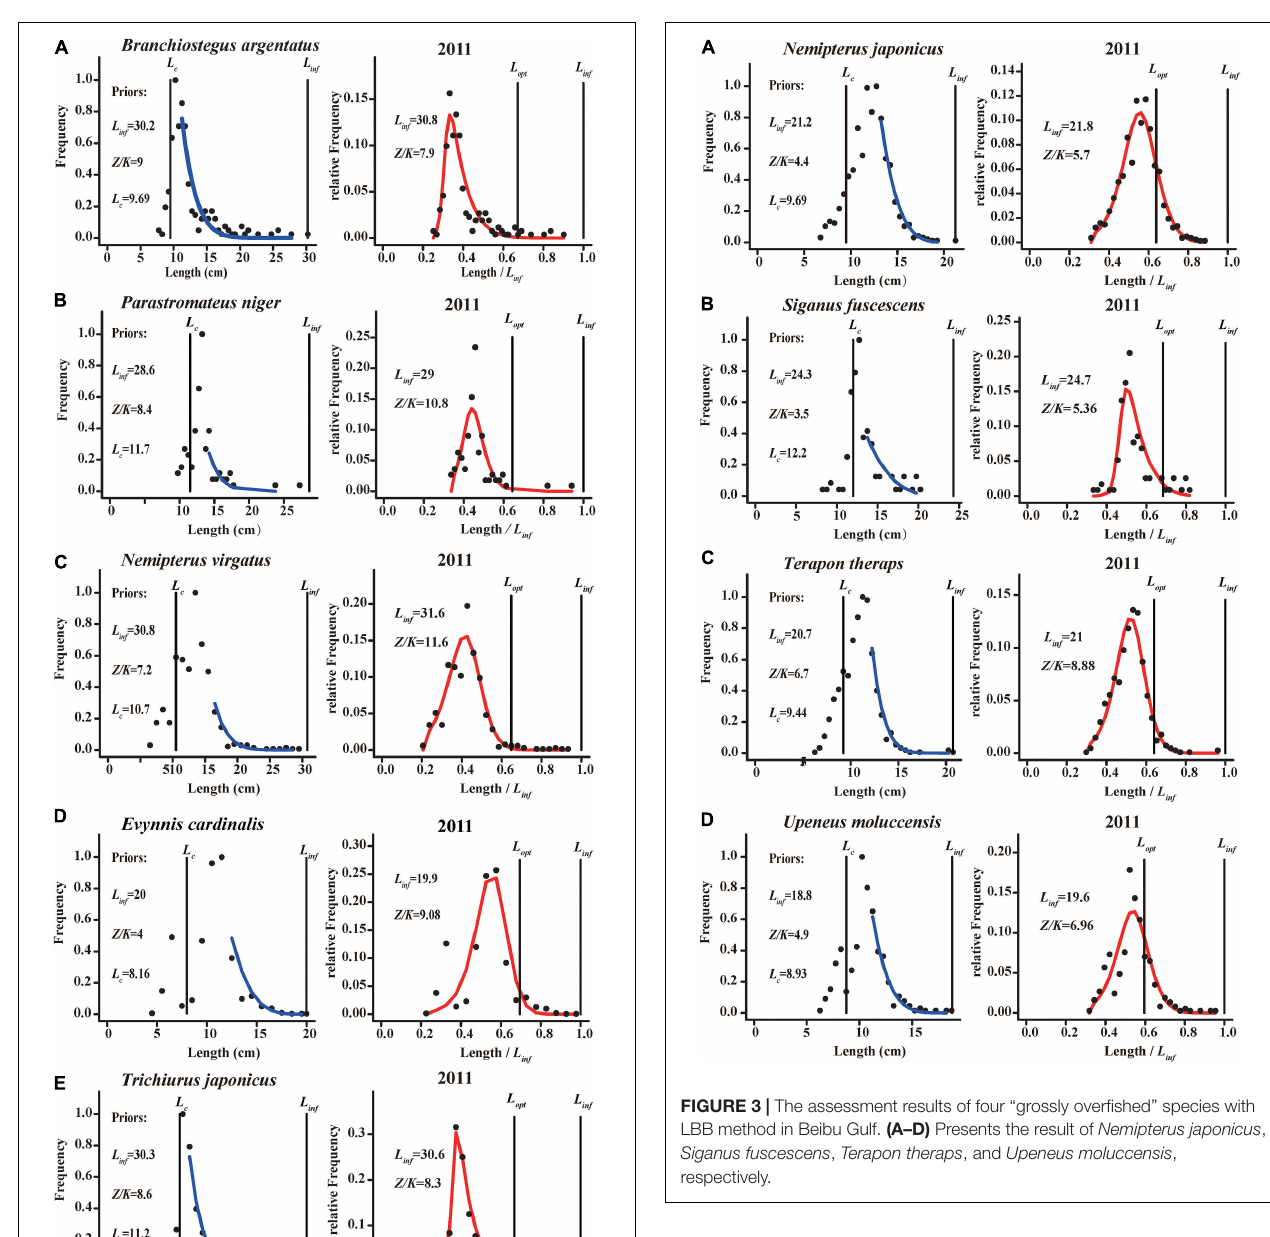
consistent with our evaluation. Trichiurus japonicus is a warm water pelagic fish, which is one of the most valuable fish species in the northern South China Sea.